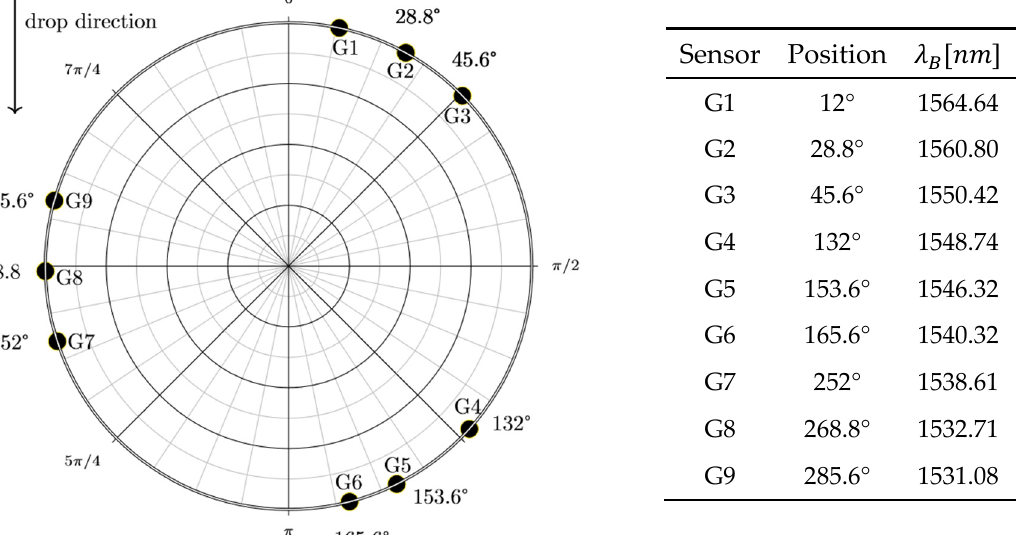
Figure 3. FBGs’ positions on the cylinder surface (graph on the left) and wavelengths (table on the right). Sensors are numbered from 1 to 9 following the radial coordinate from 12° to 285.6°.